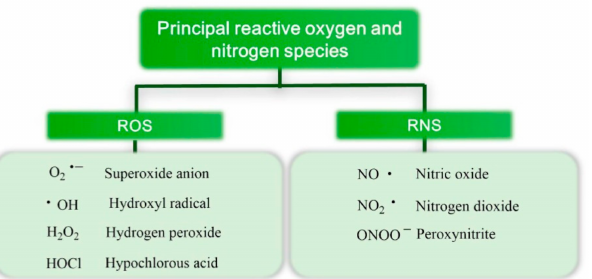
Figure 3. Principal reactive oxygen species (ROS) and reactive nitrogen species (RNS) present in the human